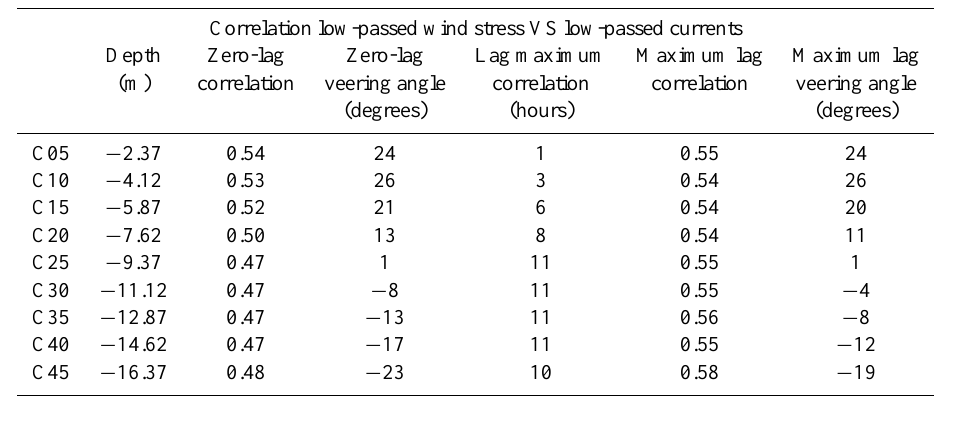
Table 5. Lagged vector correlation between wind stress and low-passed non tidal currents. Amplitude and angular offset of correlation at zero-lag are shown in 3rd and 4th columns, while columns 5th to 7th give the lag at which correlation is maximized, the amplitude of correlation and the angular displacement at the corresponding lag. First and second columns contain, respectively, the code and the depth of each ADCP cell.